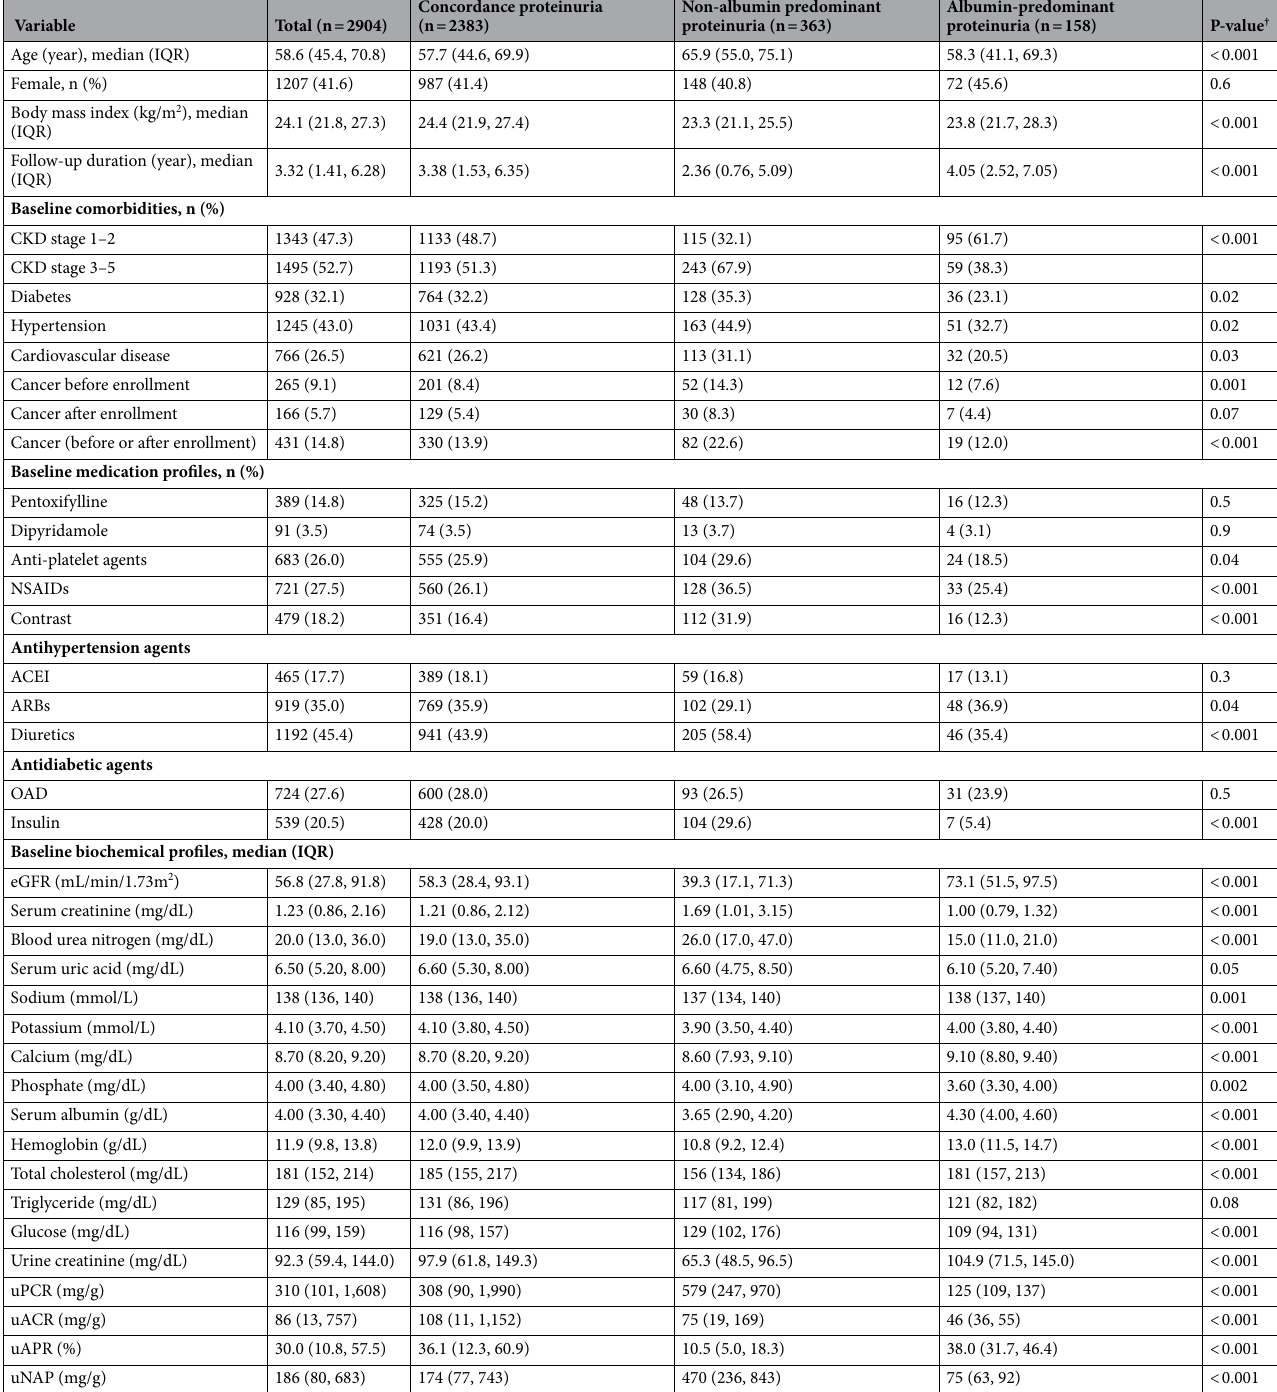
Table 1. Baseline demographic and clinical characteristics stratified by the concordant pattern among categories of uPCR (< 150, ≧ 150 to < 500, and ≧ 500 mg/g creatinine) and uACR (< 30, ≧ 30 to <